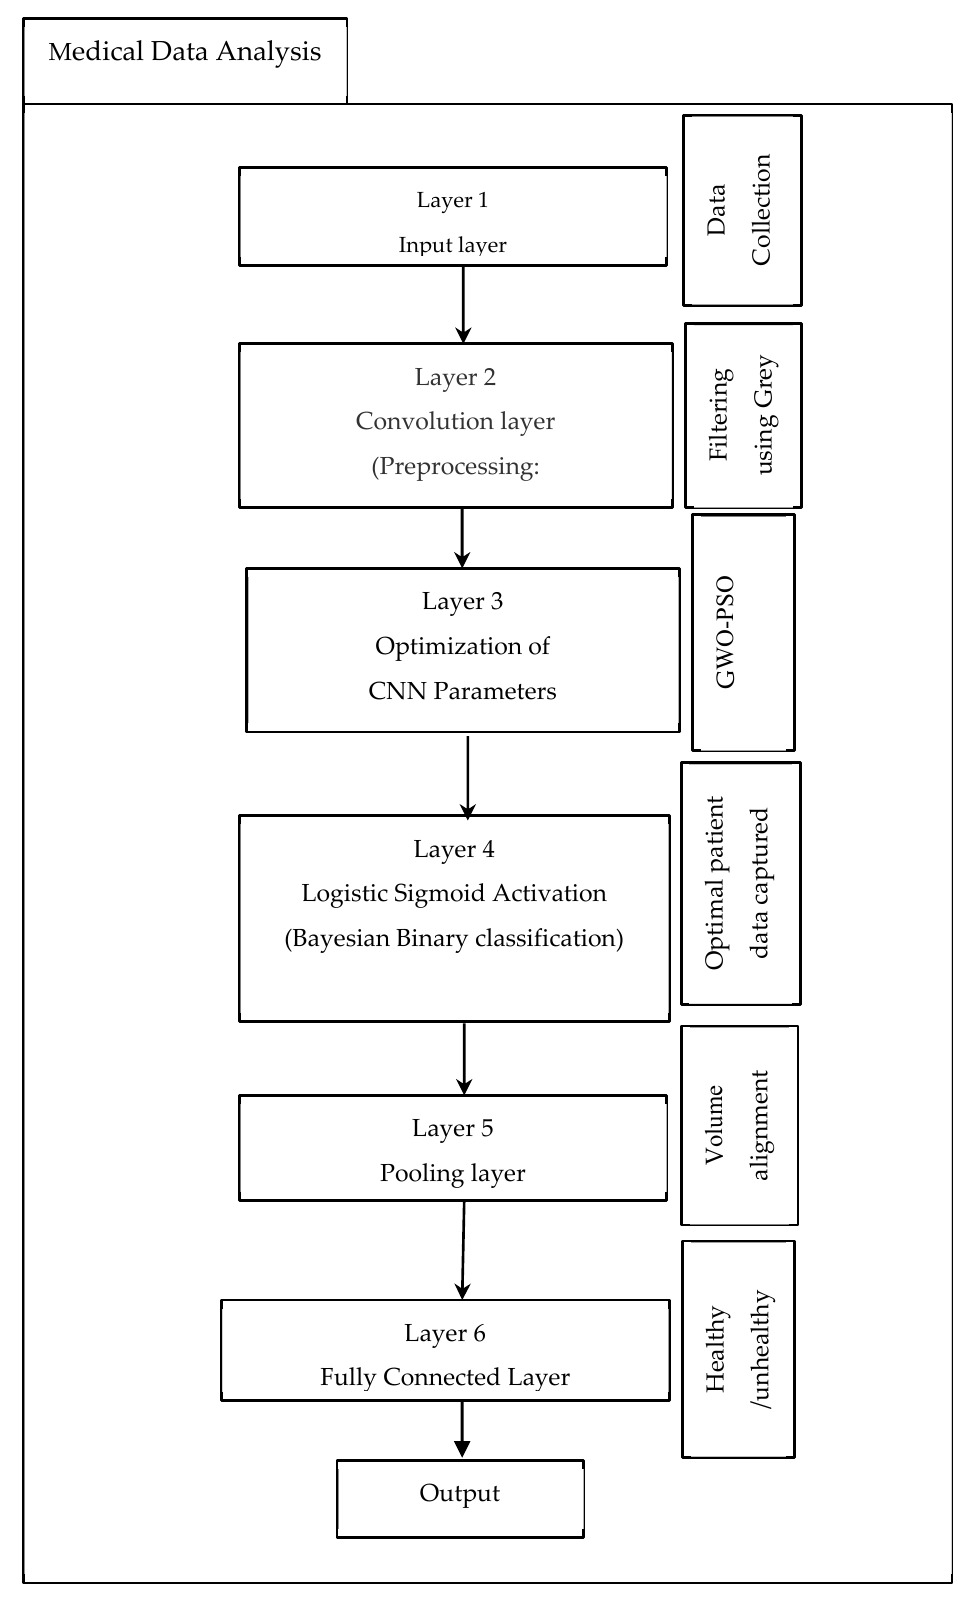
Figure 2. Medical Data Analysis Procedure using CNN.